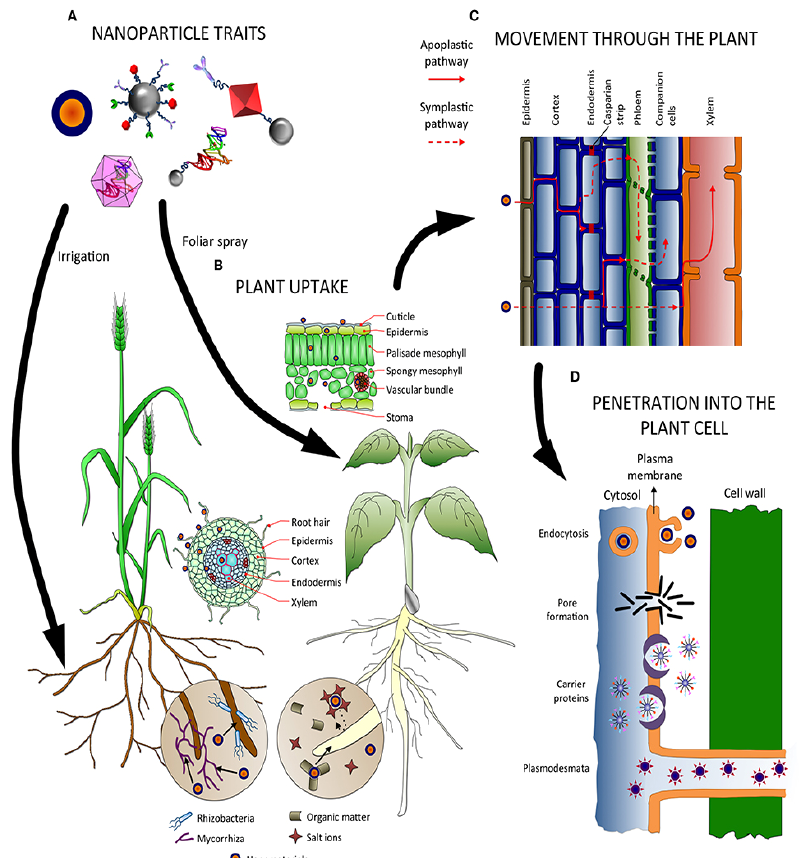
Figure 2. Factors influencing absorption, uptake, transport, and penetration of nanoparticles in plants.( A ) Nanoparticle traits affect how they are taken up and translocated in the plant, as well as the application method. ( B ) In the soil, nanoparticles can interact with microorganisms and compounds, which might facilitate or hamper their absorption. Several tissues (epidermis, endodermis) and barriers (Casparian strip, cuticle) must be crossed before reaching the vascular tissues, depending on the entry point (roots or leaves). ( C ) Nanomaterials can follow the apoplastic and/or the symplastic pathways for moving up and down the plant and radial movement for changing from one pathway to the other. ( D ) Several mechanisms have been proposed for the internalization of nanoparticles inside the cells, such as endocytosis, pore formation, mediated by carrier proteins, and through plasmodesmata [58]. The effects of different Zn and ZnO-NPs concentrations in tomatoes and wheat were evaluated by Amooaghaie et al. [59]. Results showed that Zn and ZnO-NPs help in germinating seeds and boosting growth parameters at lower concentrations, while NPs decrease these characteristics at higher concentrations. However, dissolved zinc (3–23 mgL − 1 ) to form NPs had no significant impact on either of the species’ germination fac- tors. Among different concentrations of ZnO-NPs, foliar spraying at 50 ppm gave the maximum result in the case of shoot length (30.1%), shoot fresh mass (27.7%), shoot dry mass (29.0%), root length (28.7%), root fresh mass (26.1%), root dry mass (24.6%), and leaf area (24.1%), SPAD chlorophyll content (32.1%), the fruit number per plant (21.1%), and fruit yield (19.4%) over control [36]. Rosa and co-workers [60] presented that the germi-